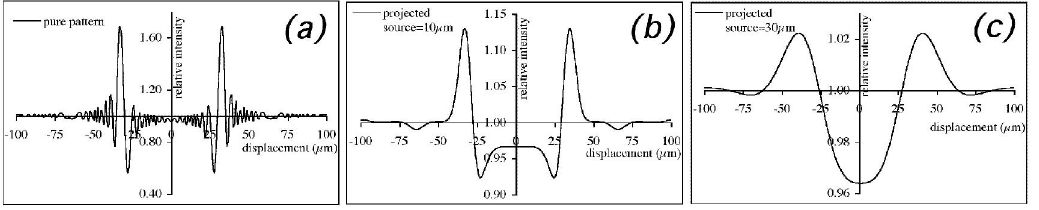
on the FSP phase contrast p